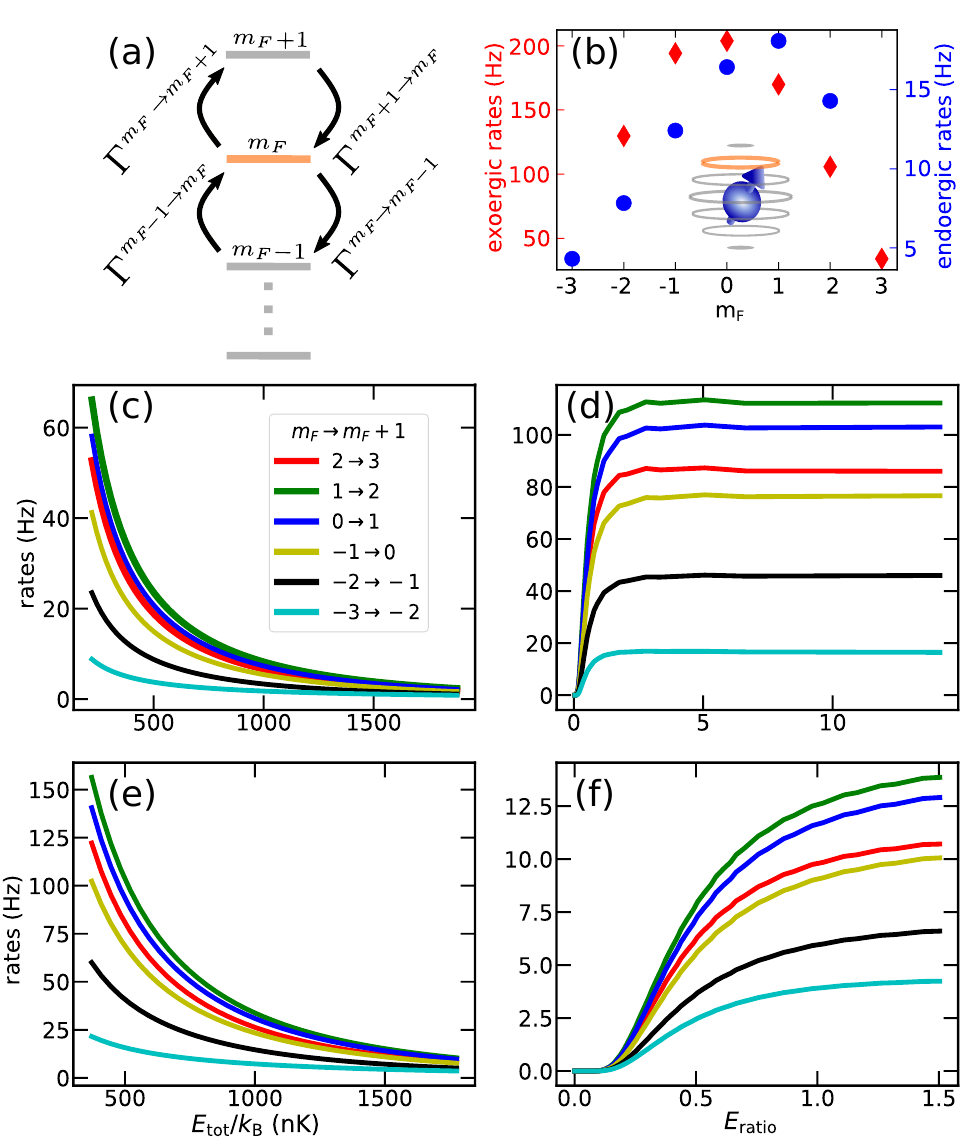
Figure 3: Spin-exchange model. For clarity, only rates between three of seven Cs states are shown in (a), resulting in a differential equation. Endoergic (blue dots) and exoergic (red diamonds) rates are shown exemplarily for B = 43mG and T = 435nK (b), which are typical values of the experiment. Total Cs spin space is illustrated as Bloch sphere in the inset. (c)-(f) present the rate dependency on the total energy = 0.3, (e) E = 1.2, and on the energy ratio for for a fixed energy ratio (c) E ratio ratio / k = 0.7 (cid:181) K, (f) E / k = 2.2 (cid:181) K. Colors in (c)-(f) label the fixed total energy (d) E tot B tot B 〉 → | m + 1 〉 different endoergic spin transfer rates for different state transitions | m F F